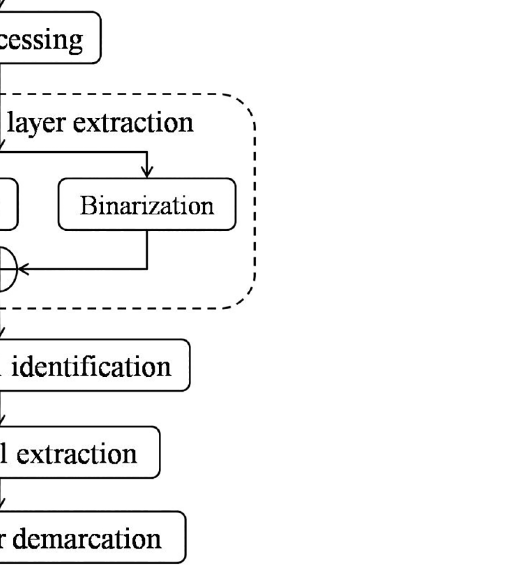
Fig 2. Schematic of proposed